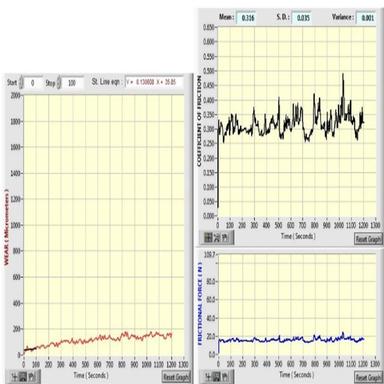
Variation of Wear rate, coefficient of force and frictional force with respect to time of Al-SiC-MgO2 FGM at 55 N, 473 rpm and 30 min wear time.